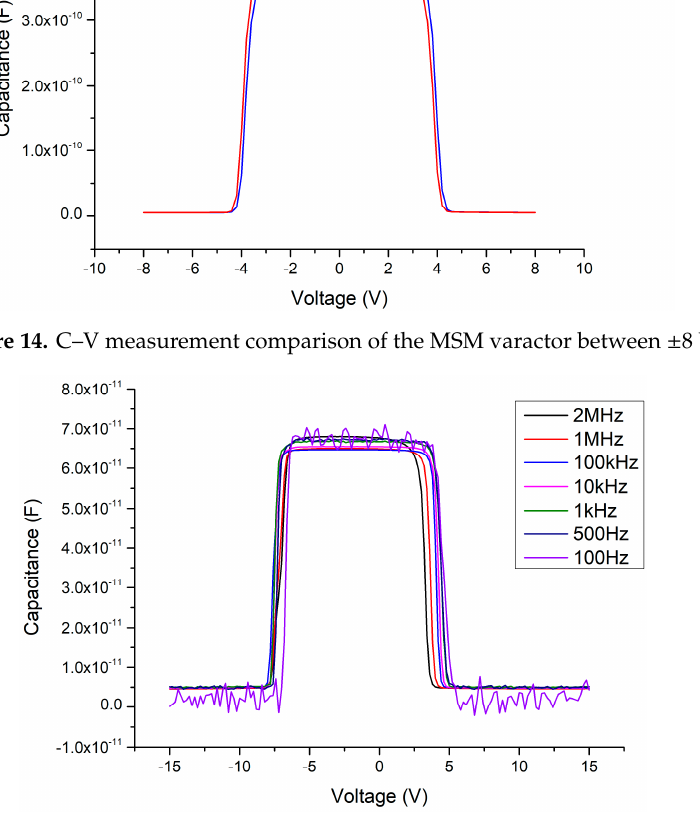
Figure 16. Threshold voltage of the MOSOM varactor. 3.4. Influence of the Oxygen Annealing Process on MOSOM’s C-V Characteristics Because the 2DEG layer results in the variable capacitance characteristic of the varactor, it should not be damaged after undergoing the oxygen furnace annealing process. Therefore, referring to the ohmic contact manufacturing process of common high-electron-mobility transistor (HEMT) devices, we utilized the lower temperature of 500 °C for the oxygen annealing experiment design. Additionally, a higher temperature of 900 °C and a longer annealing time were also utilized. As the anneal duration time is increased, the color of the gallium oxide thin-film surface tends to fade and uneven, rough particles appear on the surface of the Ga 2 O 3 thin film. This phenomenon is most obvious in the sample obtained under 900 °C and 30 min of annealing (as shown in Figure 4). Considering the influence of this process on the capacitance, under 500 °C and 2 min of annealing (as shown in Figure 17), interesting phenomena occur in the C–V pattern. First, the sweeping DC bias voltage must be expanded to ±20 V to fully measure the variable capacitance characteristics. Second, the threshold voltage of the MOSOM varactor obviously returns to a symmetrical structure, which occurs in the range of approximately ±15 V. Third, the changing pattern of the capacitance value occurs in two stages. A slight decrease occurs at about ±5 V, and the capacitance then drops completely at ±15 V. The experimental results show that the stress problem between the heterojunction and the influence of the polarization effect have been improved by the